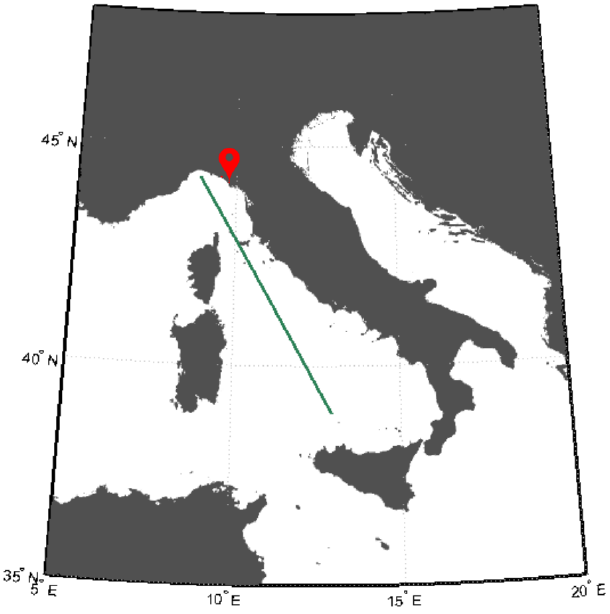
Figure 5. Map showing the WRF and WW3 models’ spatial do- mains including the Italian peninsula overlapped with the location of the video camera system (red marker) and the used OSTM/Jason- 2 satellite dataset (green